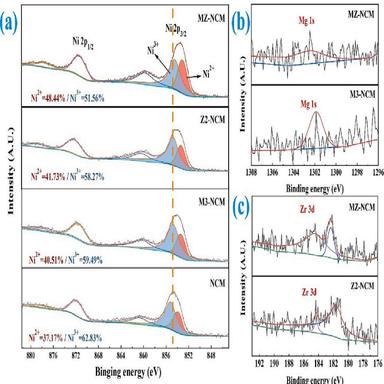
XPS spectra of the prepared samples, (a) Ni 2p, (b) Mg 1s, (c) Zr d.